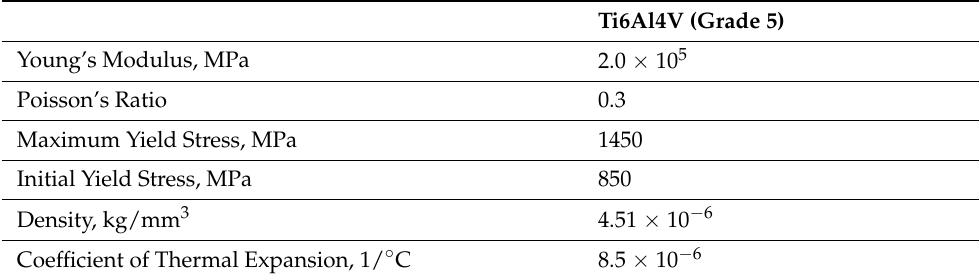
Table 1. BKS Implant properties applied in FEA [21,30].